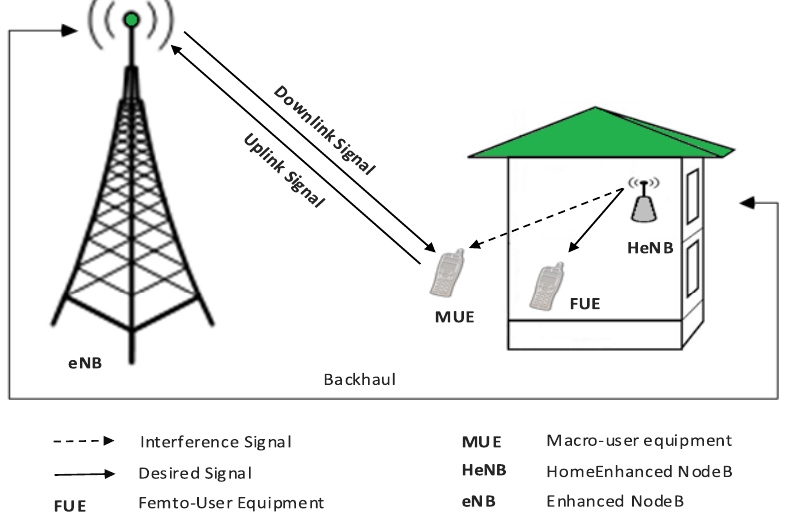
Figure 1. Interference scenario in HeNB and nearby macro and femto